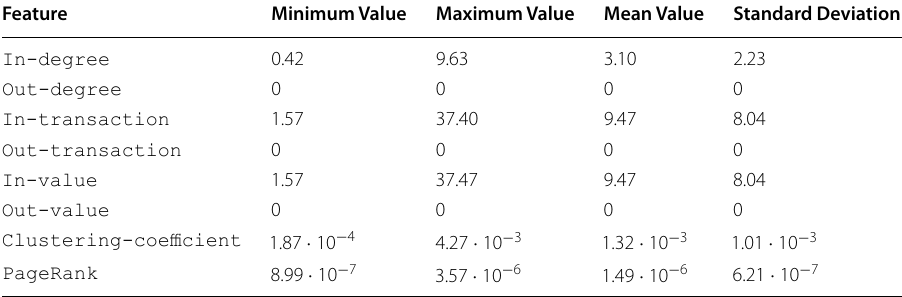
Table 7 Minimum, maximum, mean and standard deviation of the values of the spectrum features for the class